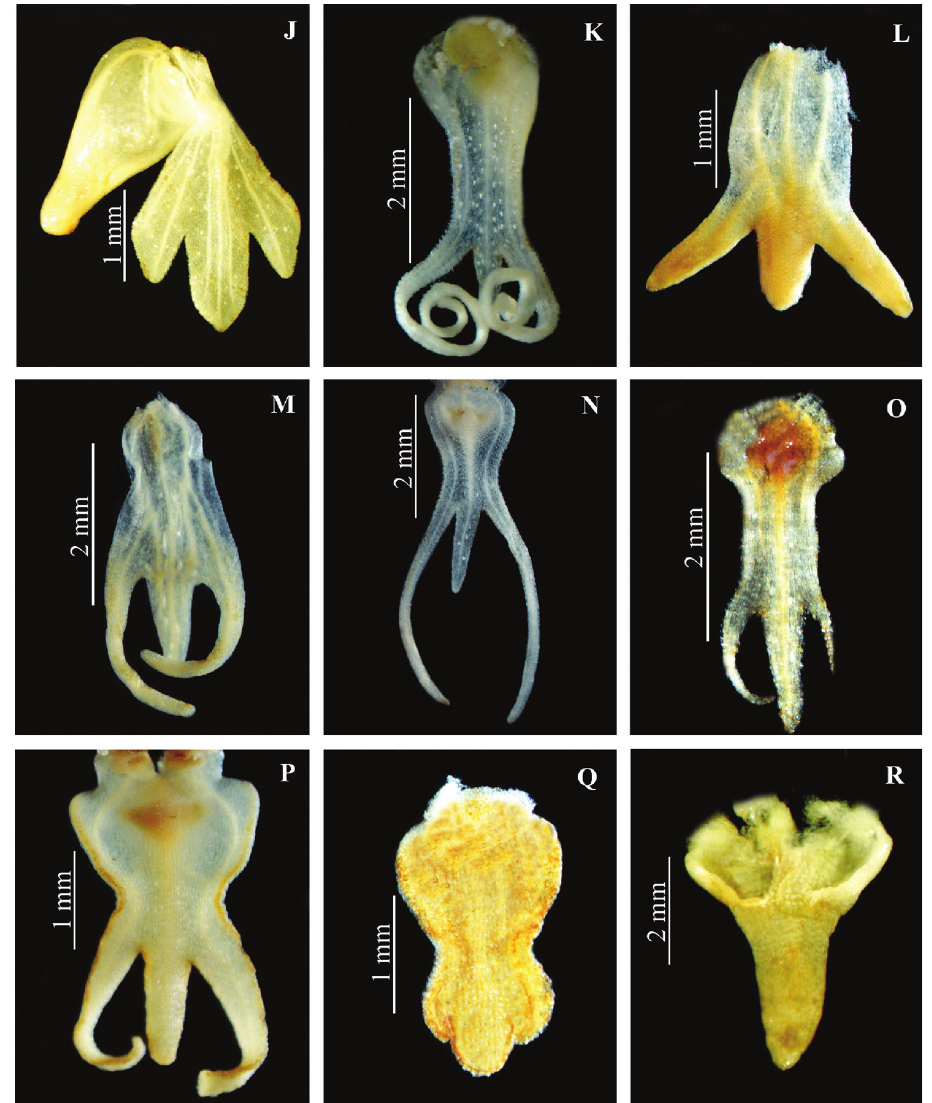
Figure 9. Continued. Lip of Herminium. J H. fallax K H. longilobatum L H. elisabethae M H. alaschanicum N H. lanceum O H. quinquelobum P H. kamengense Q H. coiloglossum R H. biporosum . H. mackinnonii , H. jaffreyanum , H. monophyllum ), lanceolate ( H. chloranthum , H. pygmaeum ), oblong-lanceolate ( H. ophioglossoides ), ovate-lanceolate ( H. macrophyl- lum , H. josephi , H. elisabethae ), ovate to broadly ovate ( H. biporosum , H. coeloceras , H.macrophyllum , H. ecalcaratum ), oblong ( H. coiloglossum ), rhombic ( H. monorchis ), or spathulate ( H. himalayanum ) (Fig.